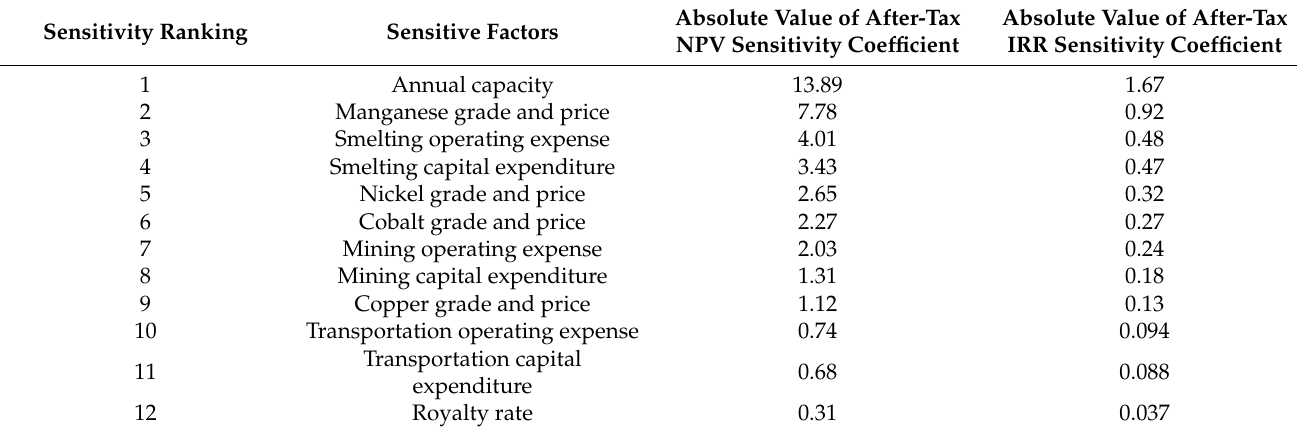
Table 7. Sensitivity coefficient and sensitivity